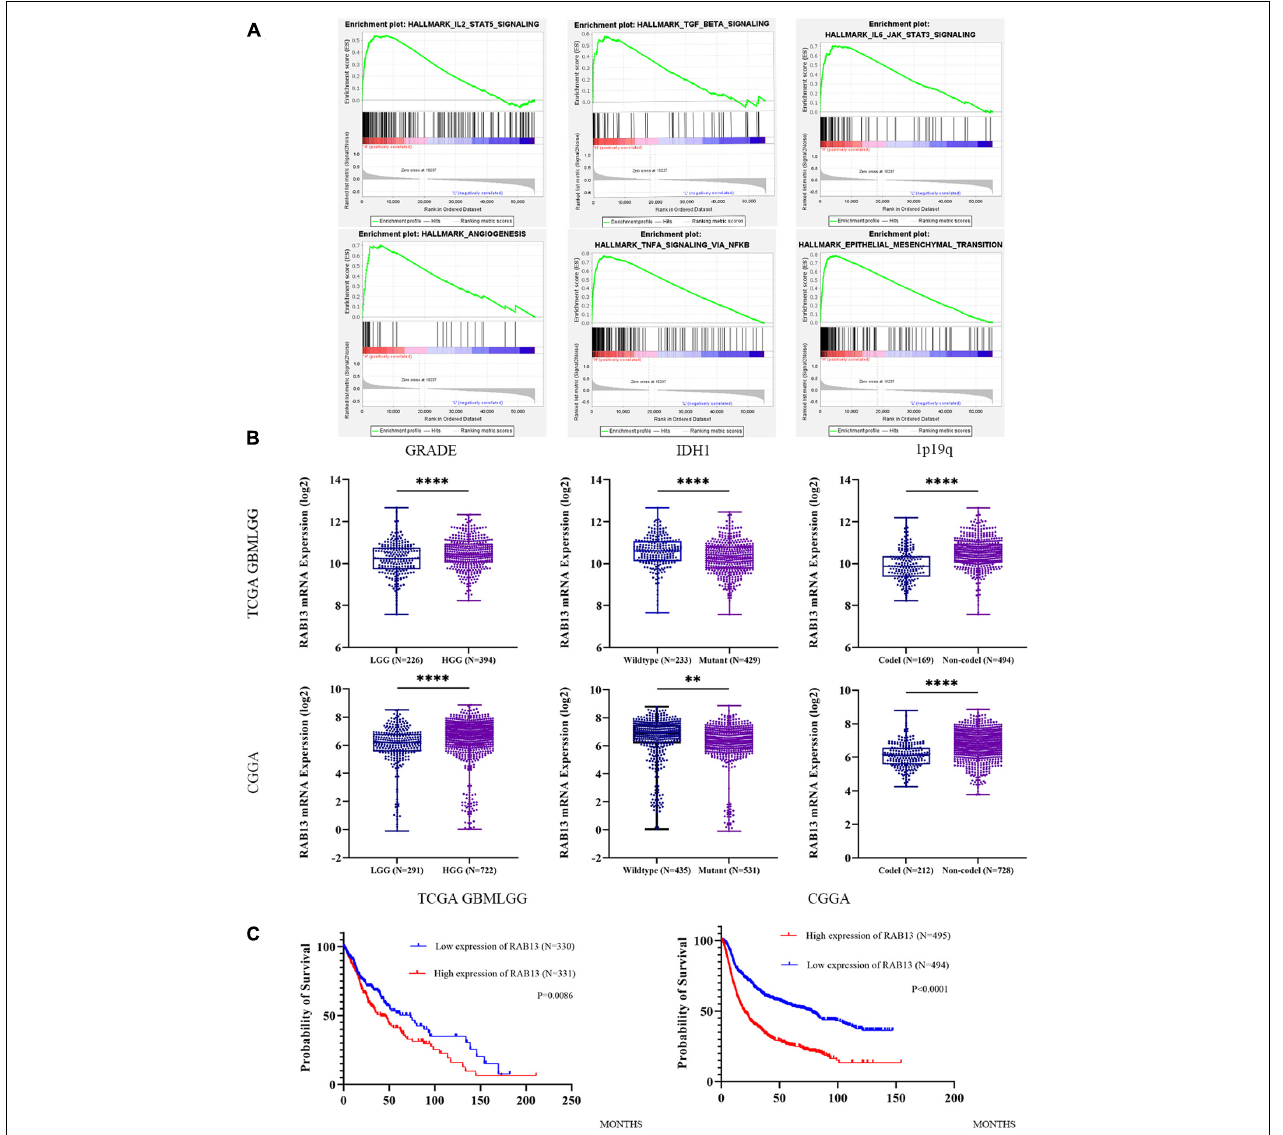
FIGURE 4 | The expression of RAB13 in the glioma database is correlated with the clinical indicators of the patient. (A) The enrichment result of RAB13 by GSEA analysis, using the TCGA database. (B) The relative expression of RAB13 mRNA in the TCGA and CGGA databases by grouping according to the grade, IDH1, and 1p19q status. (C) Correlation of expression level of RAB13 with the overall survival rate of glioma patients in the TCGA and CGGA databases. ∗∗ p < 0.01; ∗∗∗∗ p <